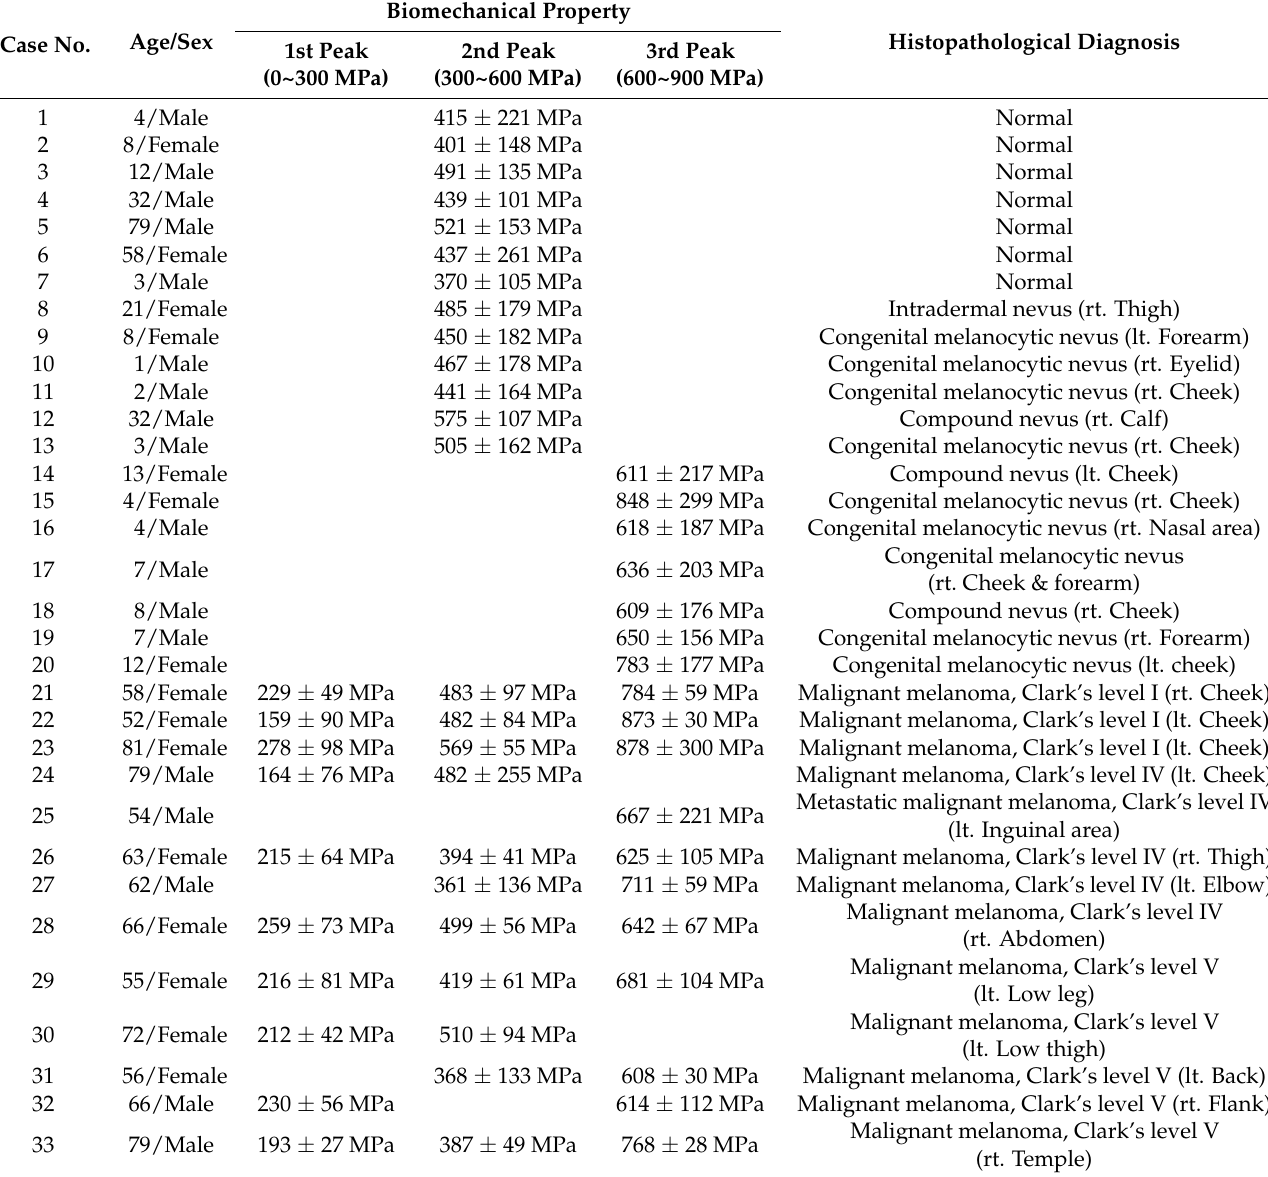
Table 1. Summary of mechanical analysis and histological examination of biopsied samples with patient information. The corresponding elastic modulus distributions are shown in Figures